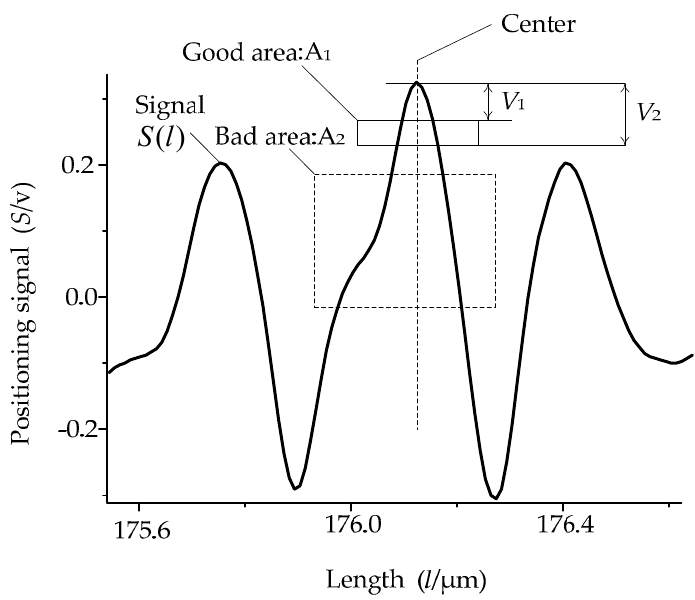
Figure 16. Positioning signal of second surface.